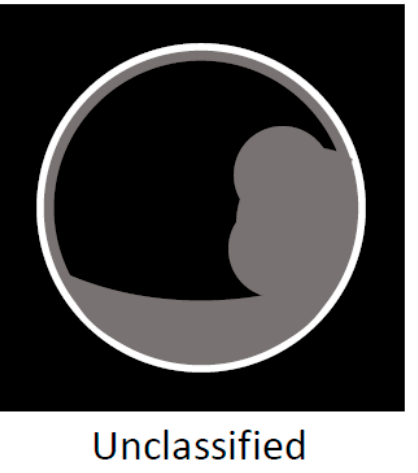
Figure 6. Schema of US/EUS findings in a localized type of IgG4-sclerosing cholecystitis. A localized IgG4-CC could be classed into the protruding type A (with smooth surface and innermost hyperechoic layer); -A’ (with smooth surface and no innermost hyperechoic layer); -B (with nodular surface and innermost hyperechoic layer); -B’ (with nodular surface and no innermost hyperechoic layer); raised-floor type (with innermost hyperechoic layer), raised-floor’ type (without innermost hyperechoic layer).